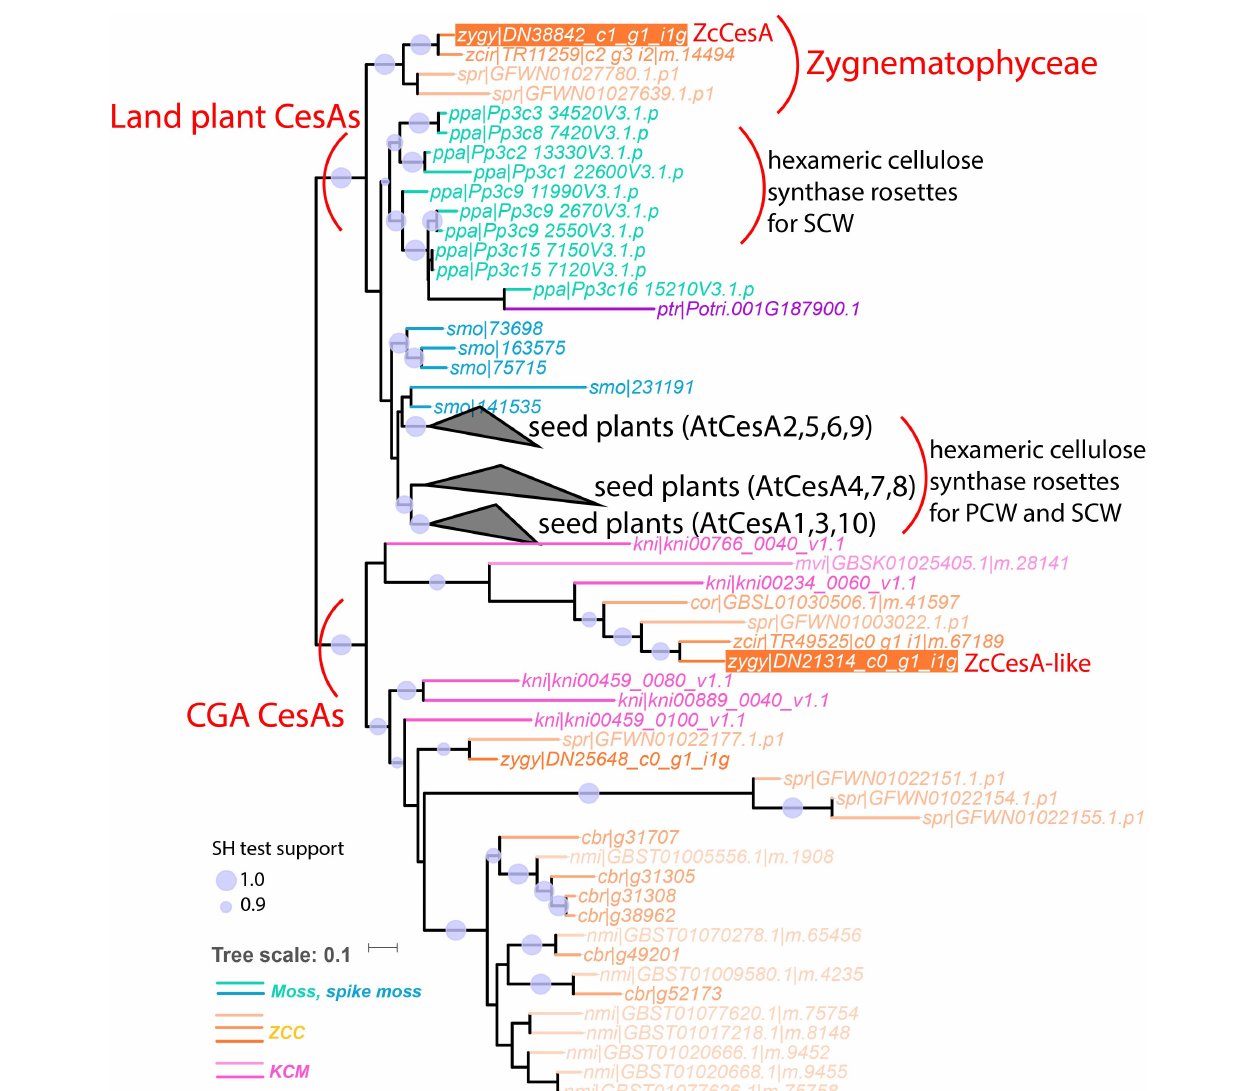
FIGURE 5 | The phylogeny with land plant CesAs and CGA CesAs (former CslD-like clade). In total 85 protein sequences of 15 plant and algal species were used to build this phylogeny (see section “Materials and Methods”). These include six proteins (leaf names contain “cbr| ”) from the sequenced C. braunii genome and 79 proteins from the CesA and CslD-like clades of Figure 3 . The three seed plant clades are collapsed as black triangles with the representative Arabidopsis proteins indicated (AtCesA 4, 7, 8 are reportedly involved in secondary cell wall cellulose synthase complex (CSC) assembly, and the rest AtCesAs are involved in primary cell wall CSC assembly). The complete version of this phylogeny is Supplementary Figure S5